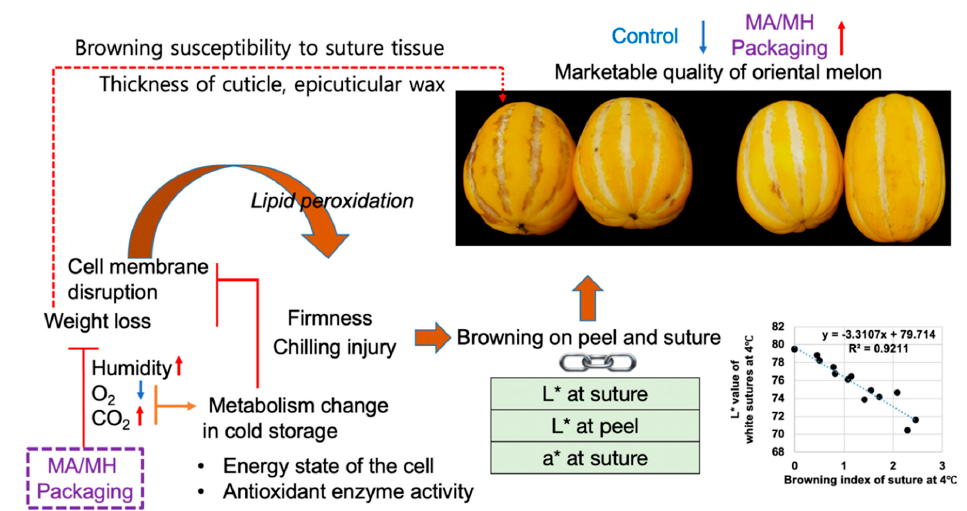
Figure 9. Modified atmosphere packaging (MAP)-mediated cold injury preventing effect on oriental melon during refrigerated (4 °C) storage. L* and a* indicate lightness and degree of redness from red to green, respectively.